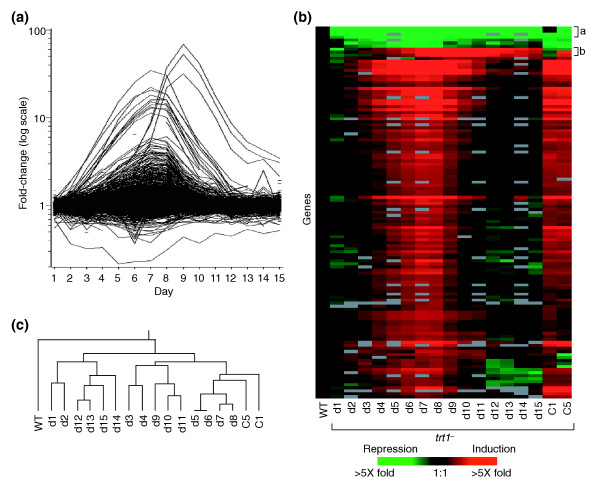
Gene-expression profiles of cells experiencing senescence and survivors. (a) Graph of expression for all genes showing fold-change relative to wild type for each day of the growth curve. Each gene is represented as a line with discontinuities resulting from missing data. For clarity, three genes (missing from the genome, see text) with expression reduced tenfold or more are not shown: trt1+, SPAC2E1P3.04 and SPAC2E1P3.05c. (b) Hierarchical clustering of the 123 genes whose expression changed by twofold or more relative to wild-type in two or more days of the growth curve (see text for details). Samples d1-d15 are days of the growth curve. Each column represents expression of all 123 genes for a unique condition. Each row represents the expression pattern of a single gene throughout all conditions. Genes shown in red had upregulated expression and those in green had downregulated expression. Values of fold-change less than 1.2 are in black, and gray areas indicate missing data. Brackets labeled with letters a-b along the right-hand side denote sets of genes with similar expression patterns for one or more conditions. Band 'a' consists of genes with downregulated expression: SPAC2E1P3.05c, SPAC2E1P3.04, trt1+ and SPBC359.02; and band 'b' represents the second wave of gene expression in the growth curve. The wild-type sample was an average of biological replicates WT 3 and WT 5. (c) Dendrogram of the experimental conditions and strains shown in (b). Experiments were hierarchically clustered on the basis of the similarity of expression ratios of the 123 genes shown in (b).